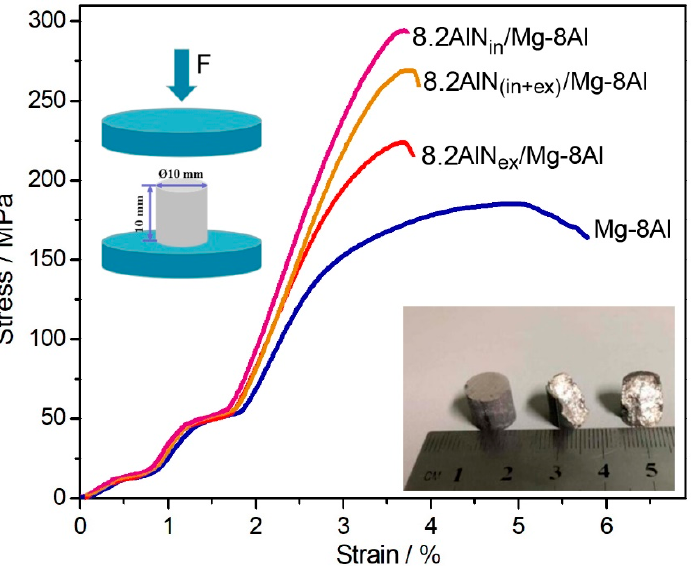
Figure 3. Typical compressive curves of the four alloys, and the inserted image shows the experimental details.